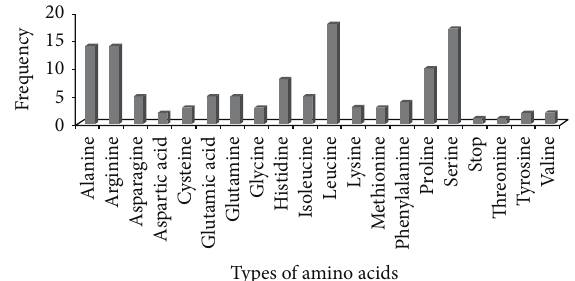
Figure 5: Details of predicted amino acids encoded by trinucleotide